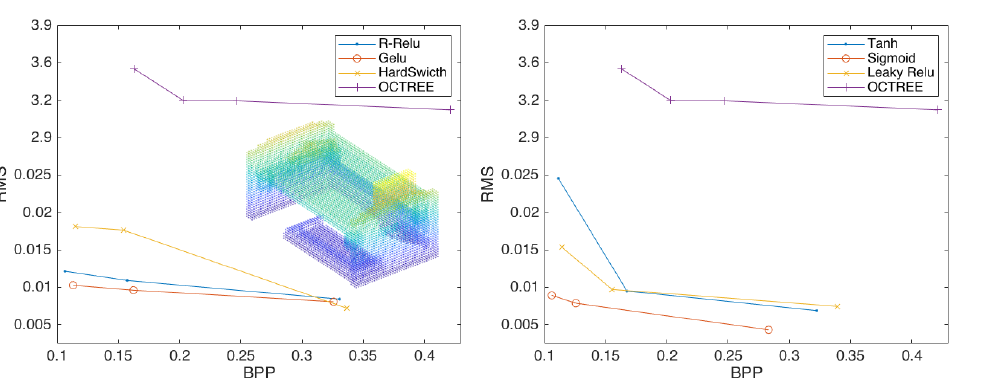
Figure 10. The compression performance of the scheme configured with four layers of convolution and two strides using the activation functions R-Relu , Gelu , and HardSwitch ( left ) and Tanh , Sigmoid , and Leaky Relu ( right